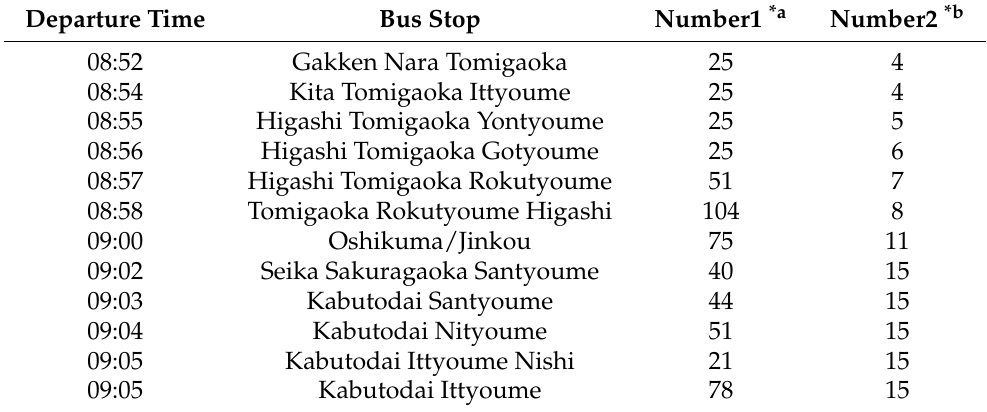
Table 3. A part of the experimental results (Gakken Nara Tomigaoka Station–Takanohara Station).